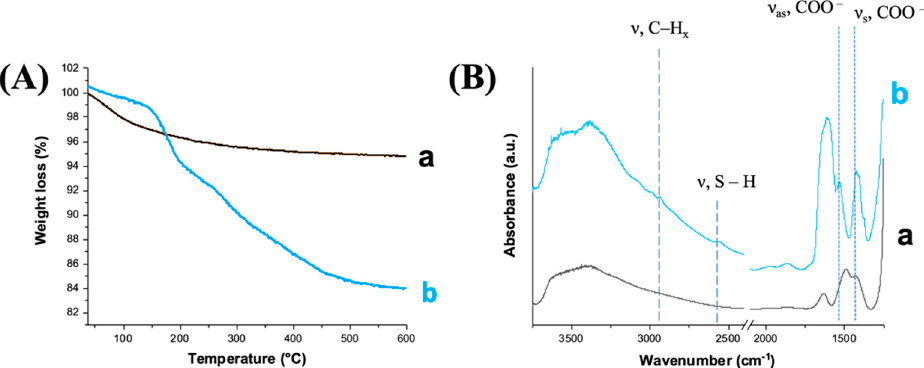
Figure 9. ( A ) TGA thermograms of (a) MBG_Sr and (b) MBG_Sr_NAC and ( B ) FT-IR spectra of (a) MBG_Sr and (b) MBG_Sr_NAC.